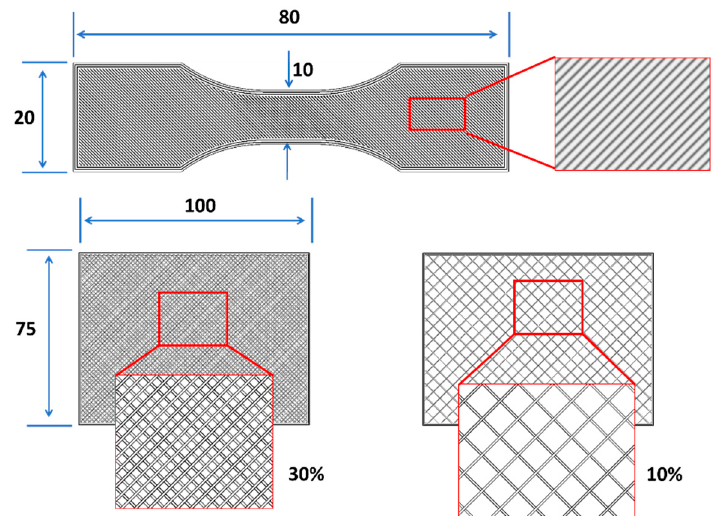
Figure 2. Sample dimensions used for PC 3D printing.